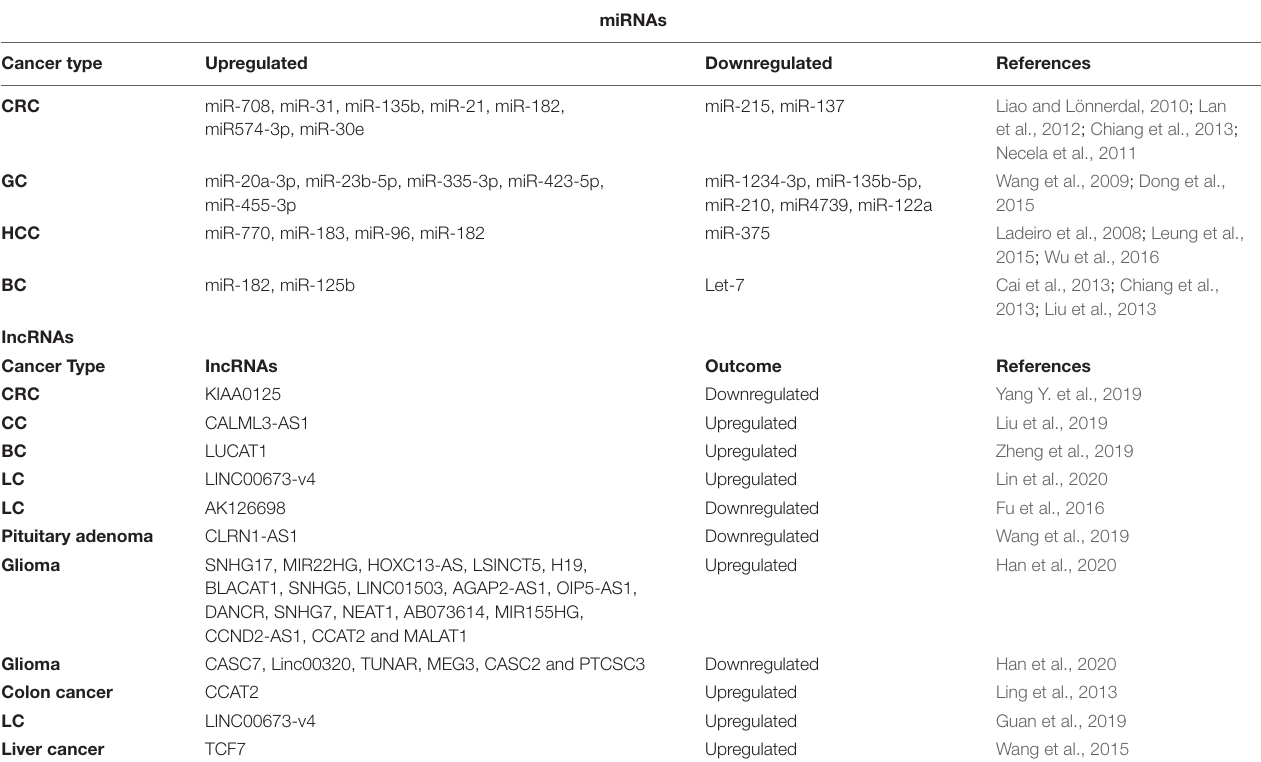
TABLE 3 | miRNAs and lncRNAs regulated by Wnt pathway in various cancer